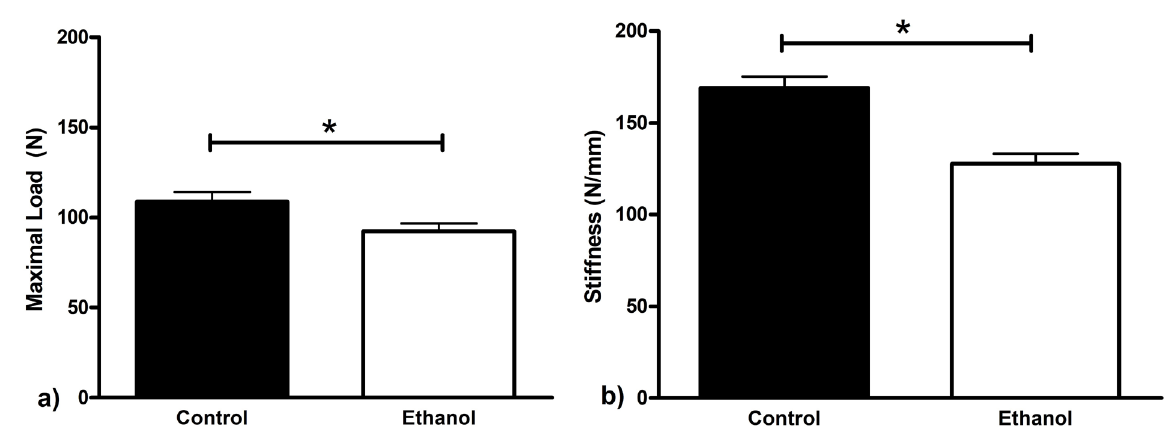
Figure 6. Analysis of mechanical resistance. a) maximal load; b) stiffness. The difference is significant (Mann Whitney test); *asterisk indicates significant difference